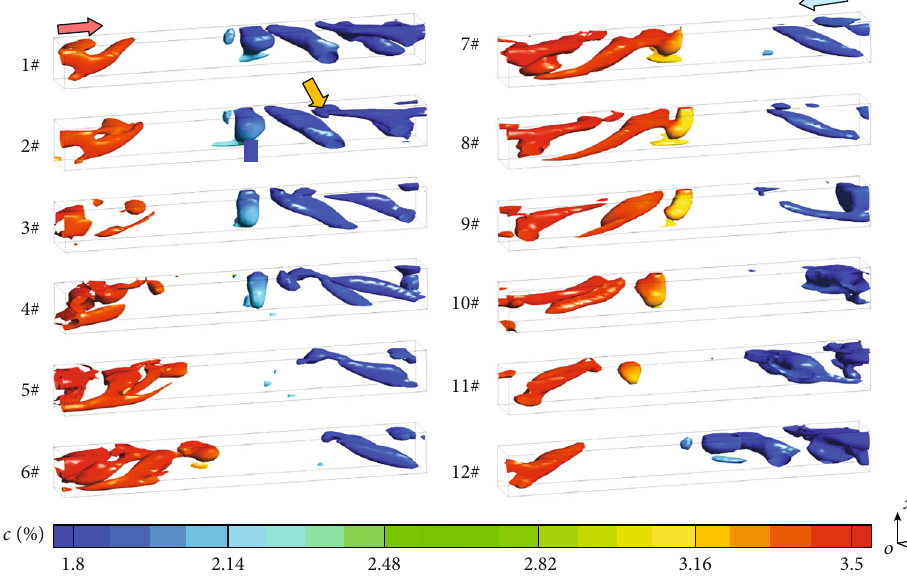
Figure 12: Q criterion isosurface ( Q = 0 : 03 ) colored by salinity magnitude in